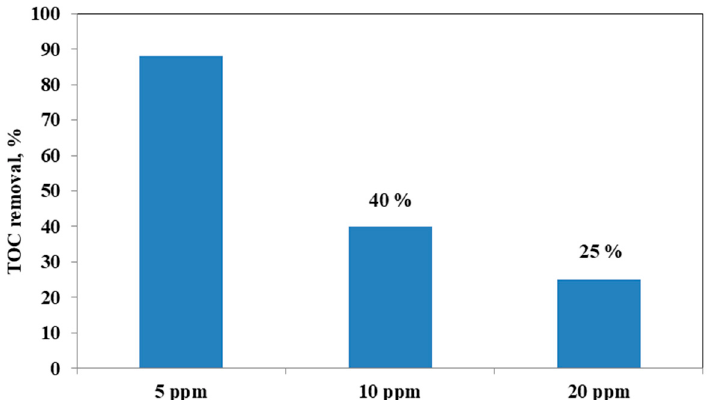
Figure 15. TOC Removal (%) after 180 min of visible light irradiation with 0.3 g of optimized Fe(2.5)-TiO 2 photocatalyst changing the AO7 initial concentration.